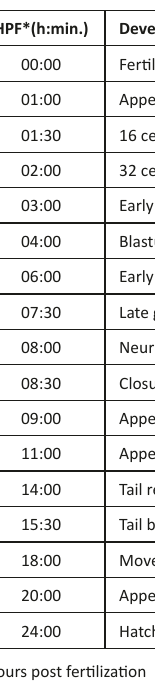
Table 2. Stages of early development in Horabagrus